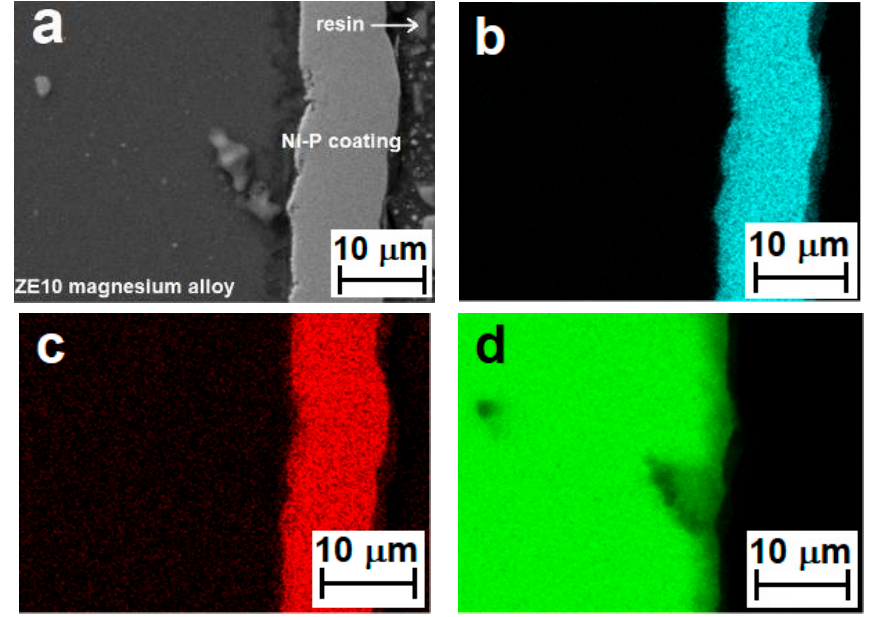
Figure 3. EDS analysis of deposited Ni–P coating on the ZE10 magnesium alloy: ( a ) a cross section of the Ni–P-coated sample, ( b ) nickel, ( c ) phosphorus, and ( d ) magnesium.